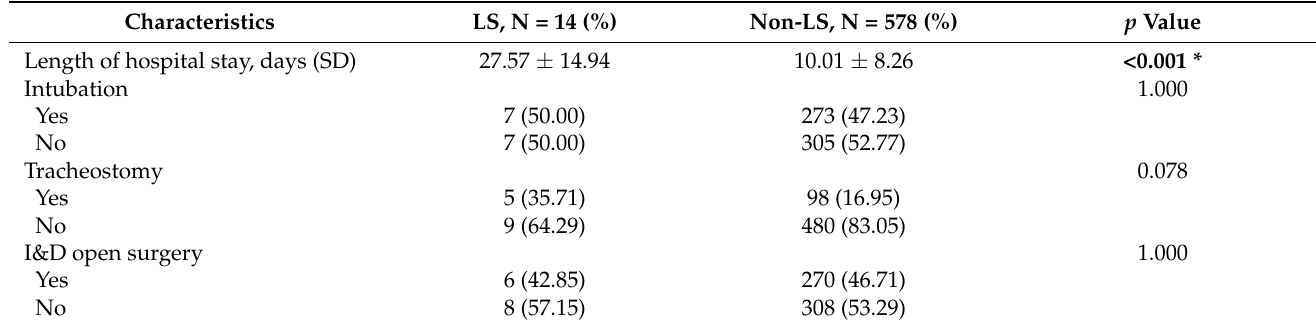
Table 3. Length of hospitalization and management of 14 patients with concurrent DNI and LS compared with those of 578 patients with DNI alone.